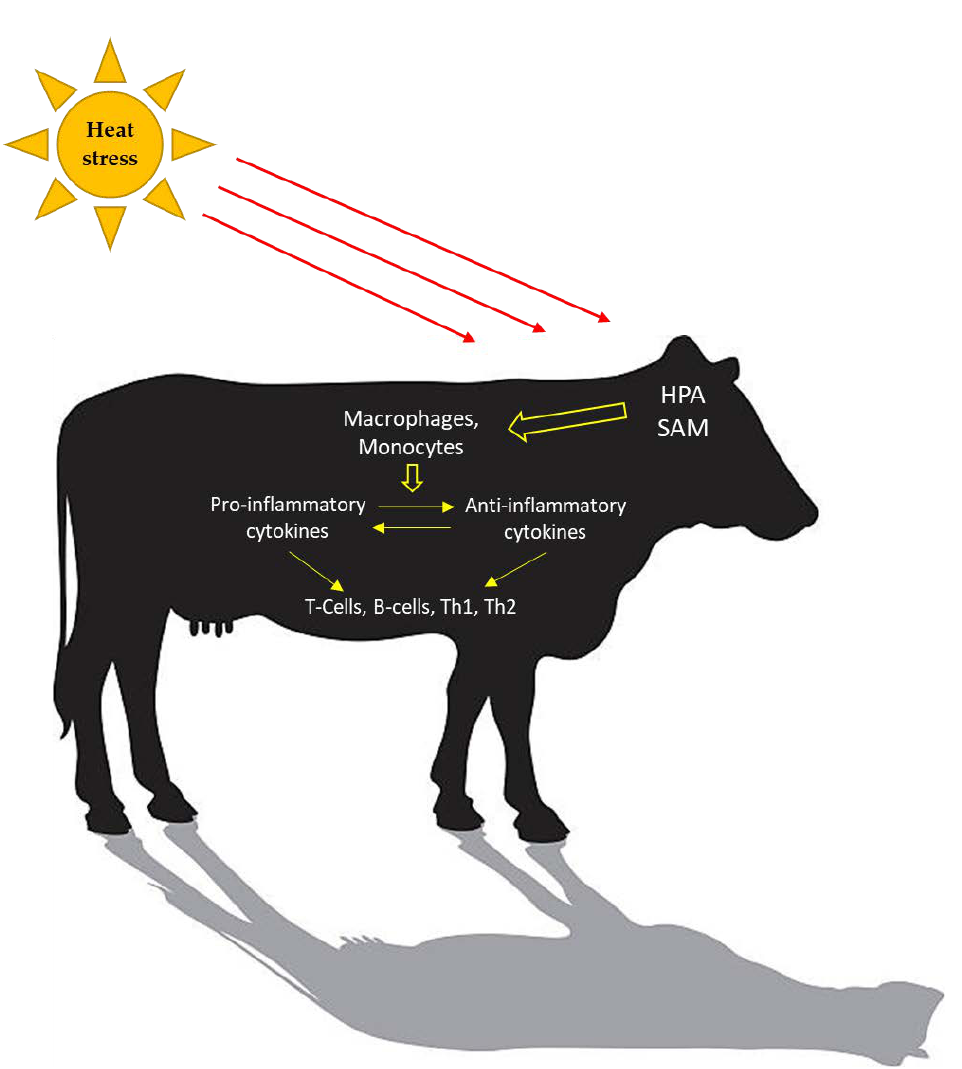
Figure 1. Heat stress activates an immune response. Concentrations of pro-inflammatory and anti-inflammatory cytokines change to maintain homeostasis. The adaptive immune system is cell-mediated (T-lymphocytes; Th1 and Th2) and humoral-mediated (B-lymphocytes).